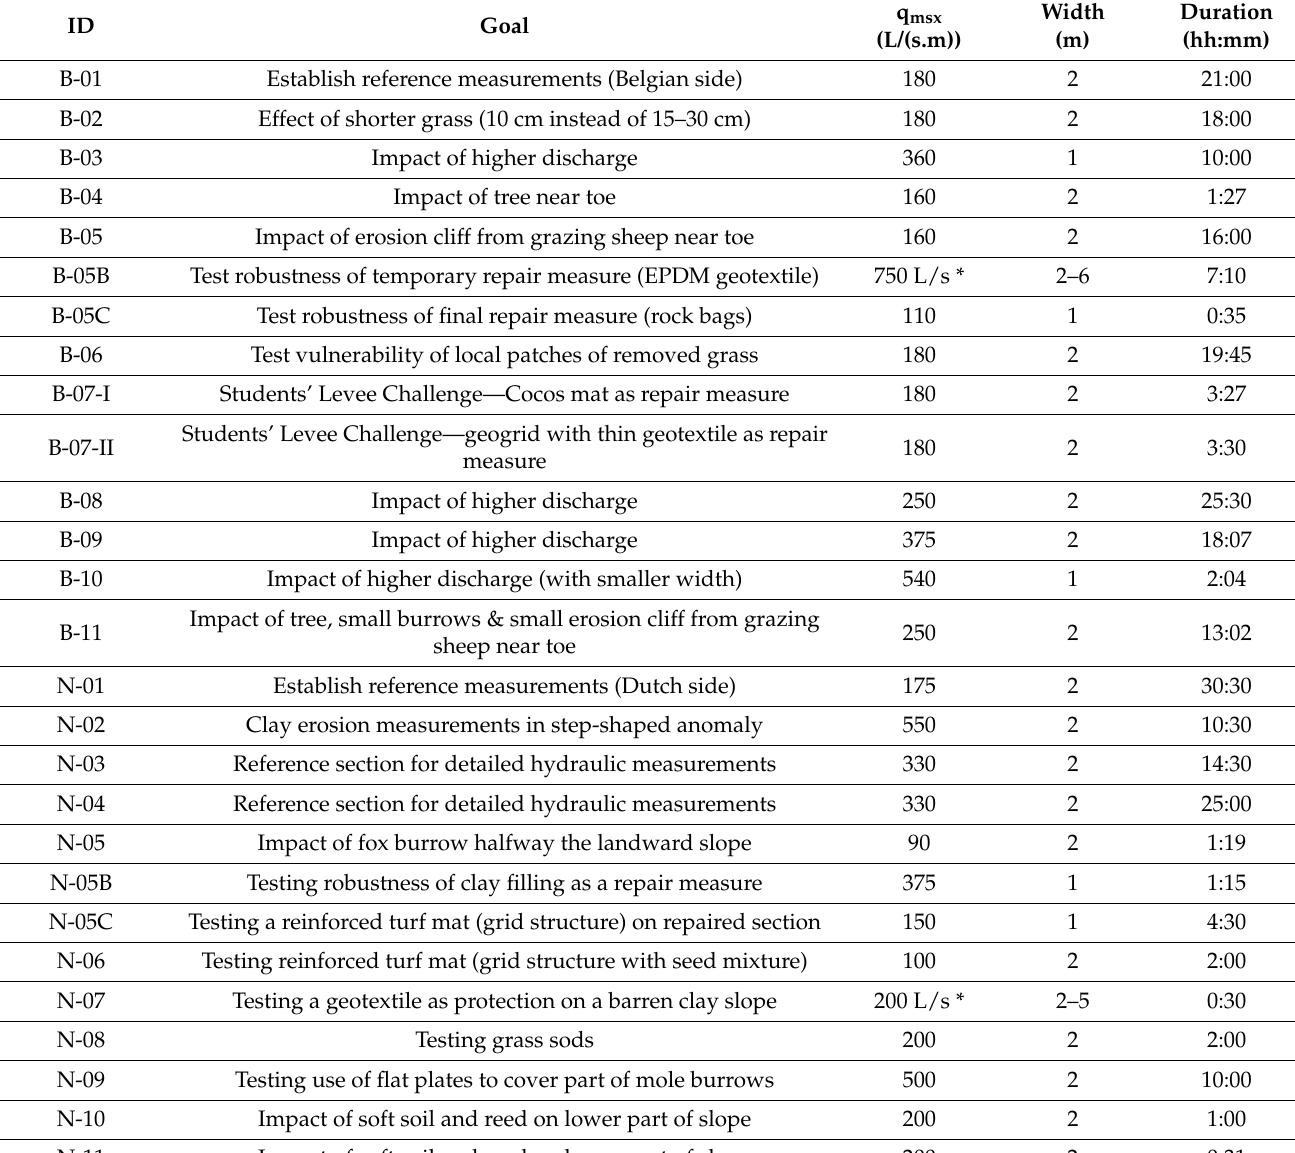
Table 1. Summary of all overflow tests (* to indicate flow over full, variable